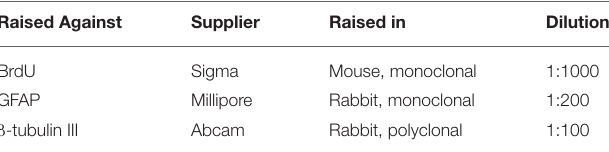
TABLE 2 | Primary